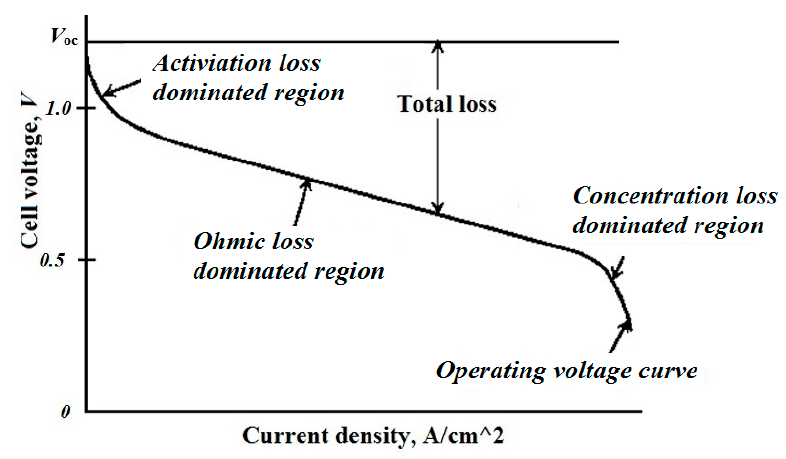
Figure 4. Voltage against current density characteristics.